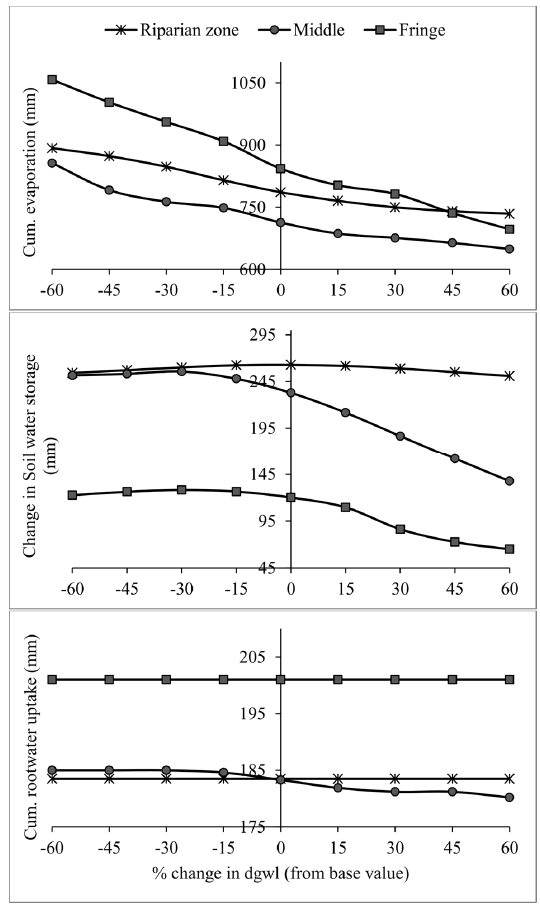
Figure 9. Sensitivity analysis for different water fluxes on changes in the depth to groundwater level; dgwl, depth to groundwater level.